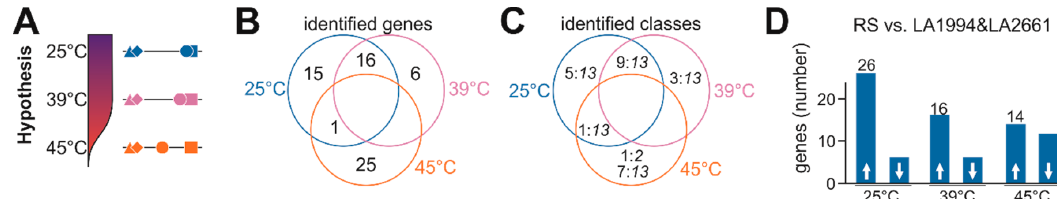
Figure 8. Analysis of genes differential regulated between HS sensitive and tolerant genotypes. ( A ) The hypothesis formulated on the basis of the physiological behavior is shown. ( B ) The number of genes selected by the described method (section 2.8) and the overlap between the individual selections is shown. ( C ) The number of genes in specific class (number:class, as in Figure 3) is shown for the distribution presented in ( B ). ( D ) The number of genes with higher (first bar) or lower (second bar) transcript abundance at 25 °C (bar 1 and 2), 39 °C (bar 3 and 4) and 45 °C (bar 5 and 6) in Red Setter in comparison to LA1994 and LA2661 is presented.